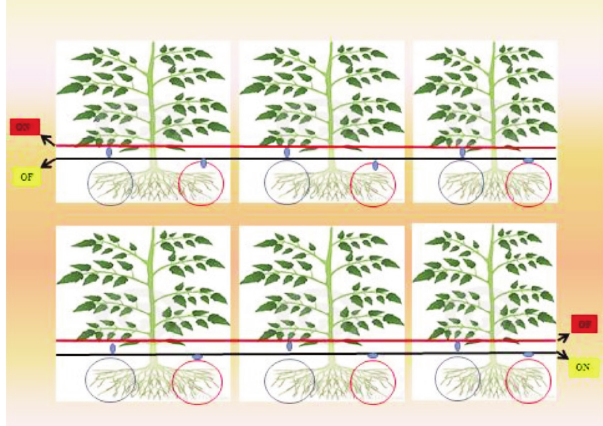
Fig. 1 - Schematic diagram of partial root-zone drying (PRD) irri- gation in tomato